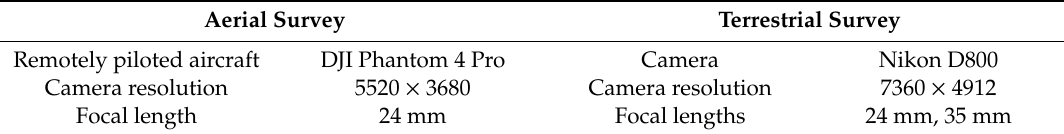
Table 1. Technical specifications of the instrumentation used for the photogrammetric survey.